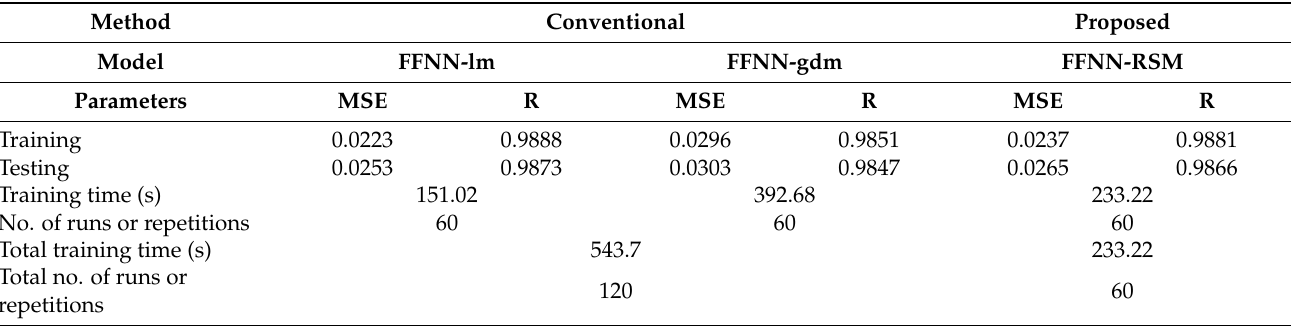
Table 7. Overall performance accuracy of the FFNN-lm, FFNN-gdm, and FFNN-RSM models for the SMBR filtration